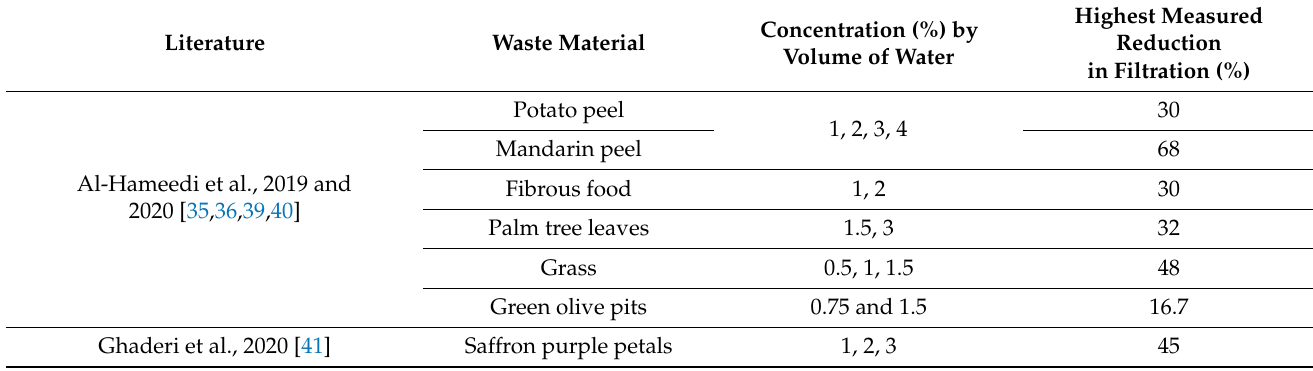
Table 1. Waste materials used to optimize the filtration properties of water-based muds. Literature Waste Material